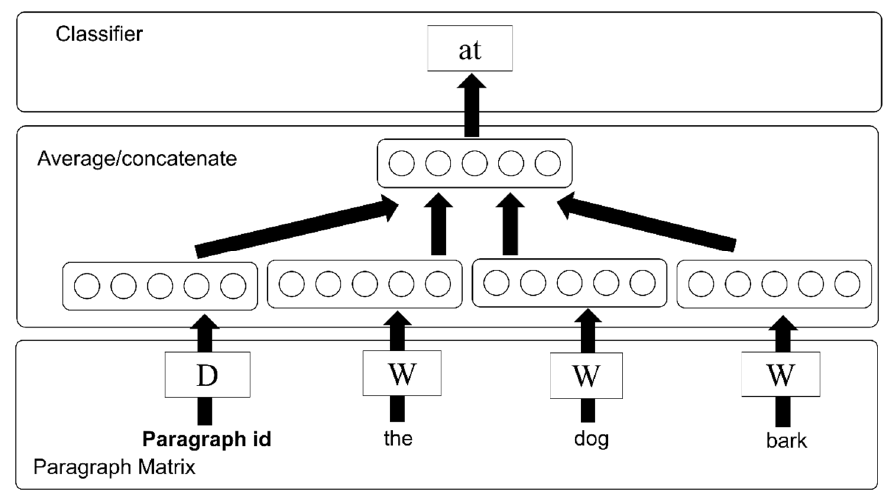
Figure 2. Framework for training the paragraph vector.